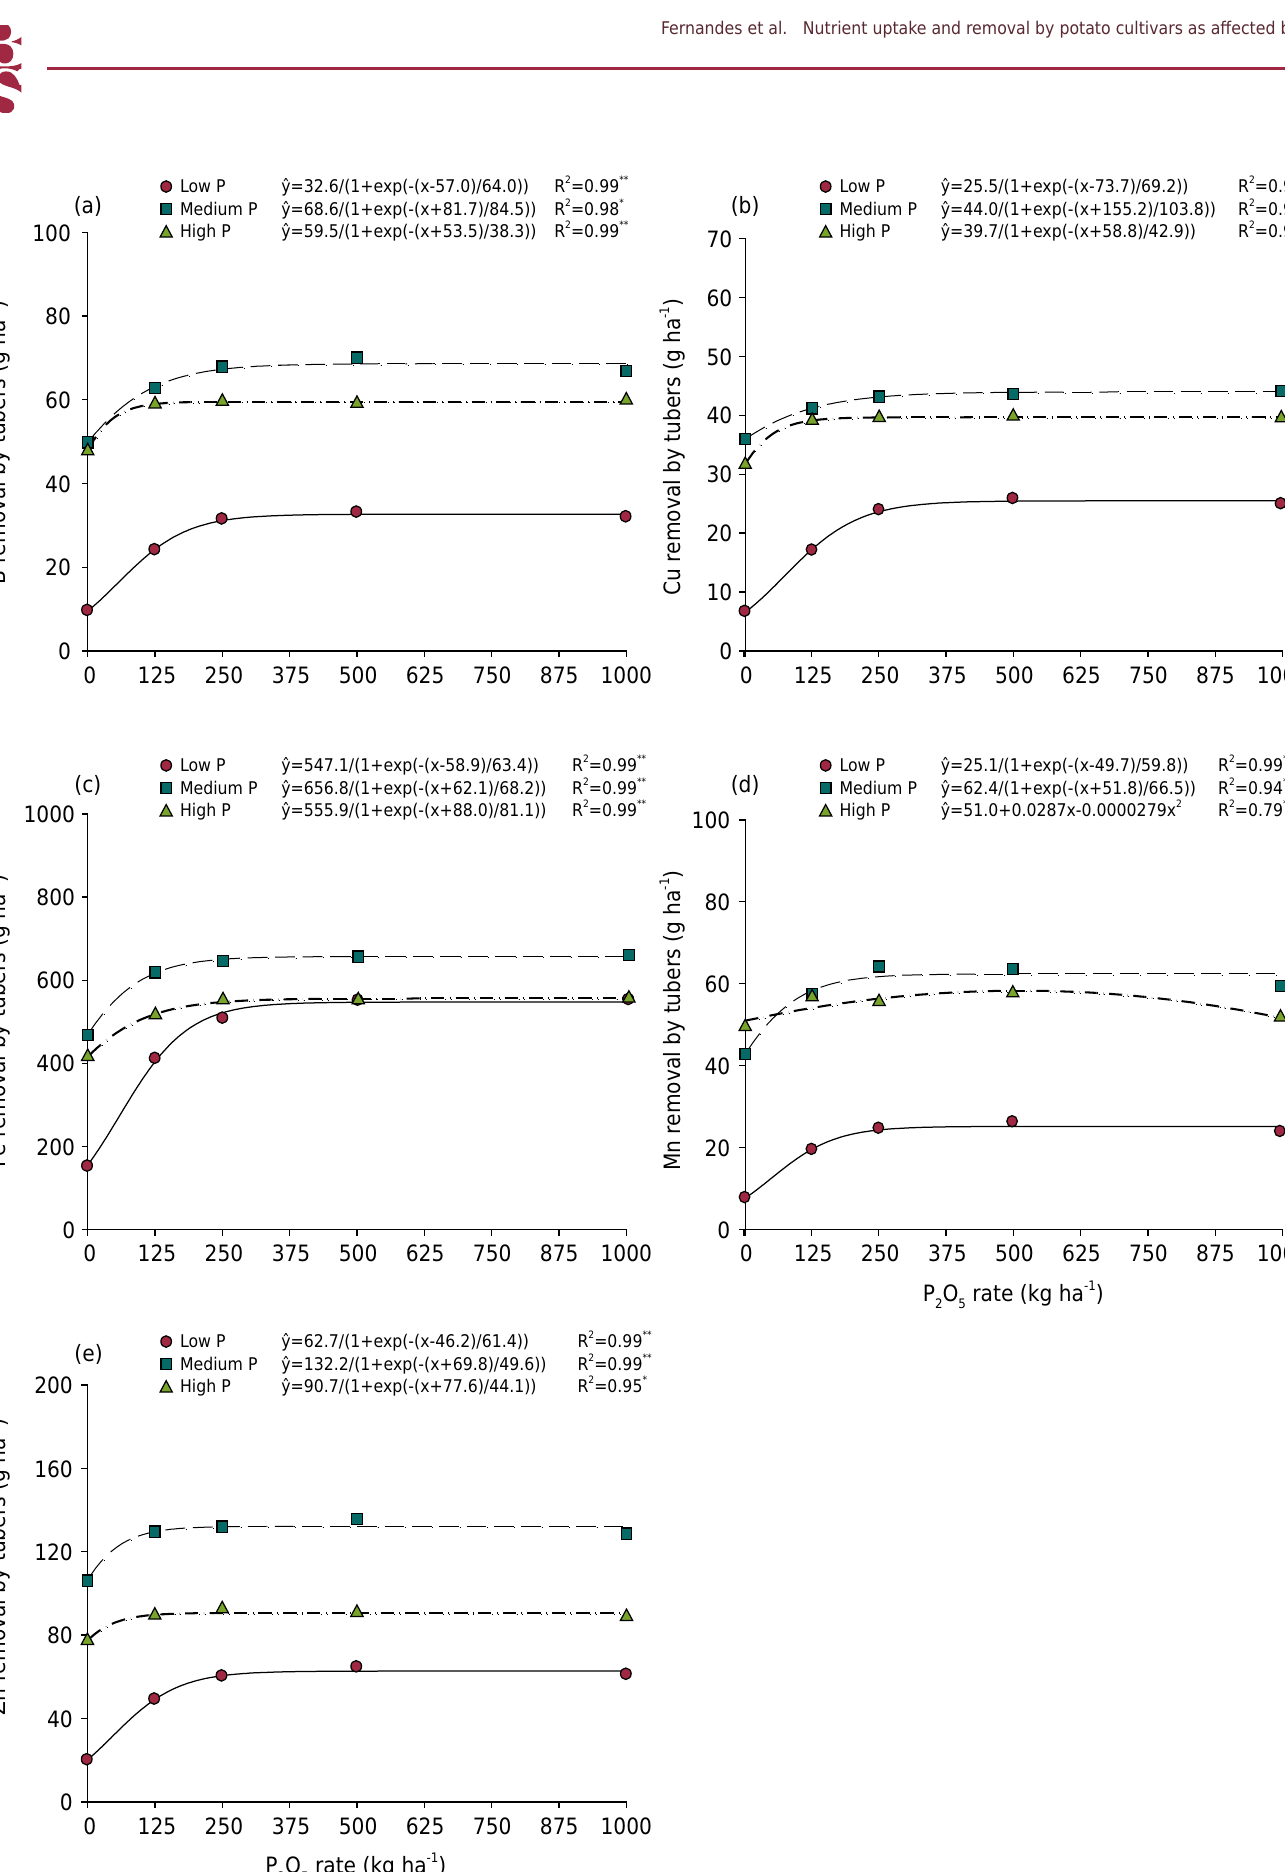
Figure 7. Removal of B (a), Cu (b), Fe (c), Mn (d), and Zn (e) by potato tubers as affected by rates of P applied in the planting furrow in soils with low, medium, and high P availability. Means of five cultivars. * and ** : significant at 5 and 1 % by the F